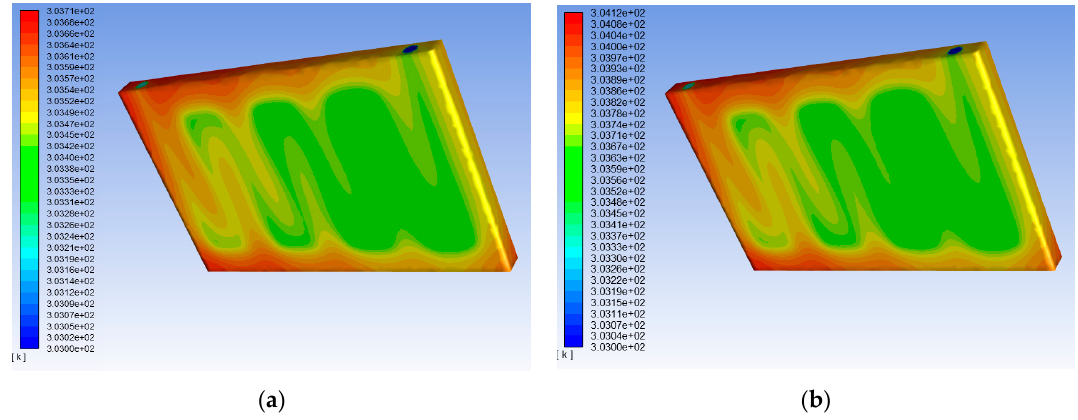
Figure 10. The temperature profile for different ambient temperature: ( a ) 303 K and ( b ) 313 K.